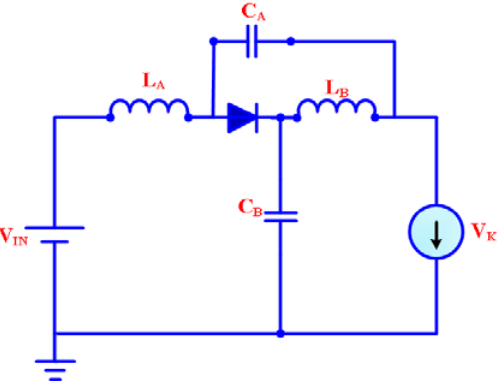
Figure 8. The equivalent model of Quasi Z ‐ source inverter governing non ‐ shoot through the state.